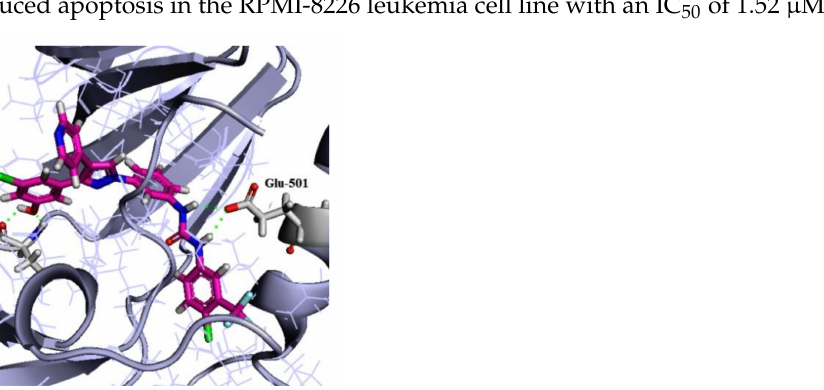
Figure 74. In silico binding interactions of compound 71 with V600E-B-RAF crystal structure [84].